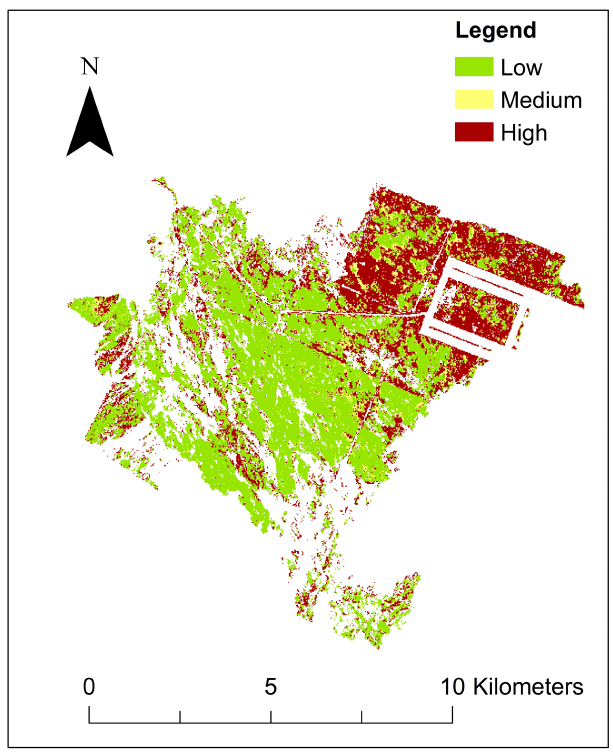
Fig. 3 . Fire-severity map of Hajdukovich Creek burn located in southwestern game management unit 20D.